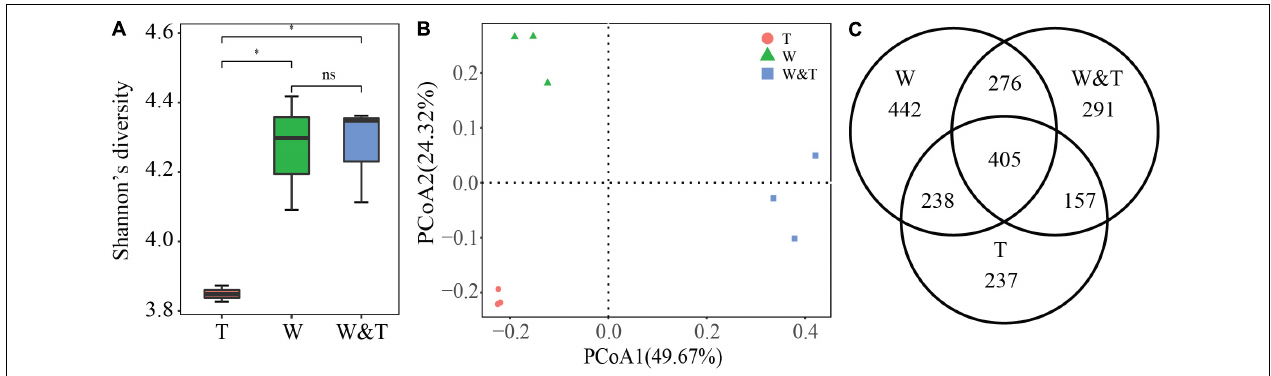
FIGURE 5 | Fungal community α -diversity and β -diversity. (A) Shannon’s diversity for fungal communities in monoculture tea forest (T), monoculture walnut forest (W), and intercropping forest (W&T). A box indicates the interquartile range; a black line indicates the median value. A lowercase letter on each box represents a least significant difference (LSD, p < 0.05) between the T, W, and W&T. Asterisks indicates significant differences ( ∗ p < 0.05). (B) Principal coordinate analysis (PCoA) plots based on the Bray–Curtis distance demonstrating the separation between soil fungal communities of three forest types. (C) The Venn diagram shows the